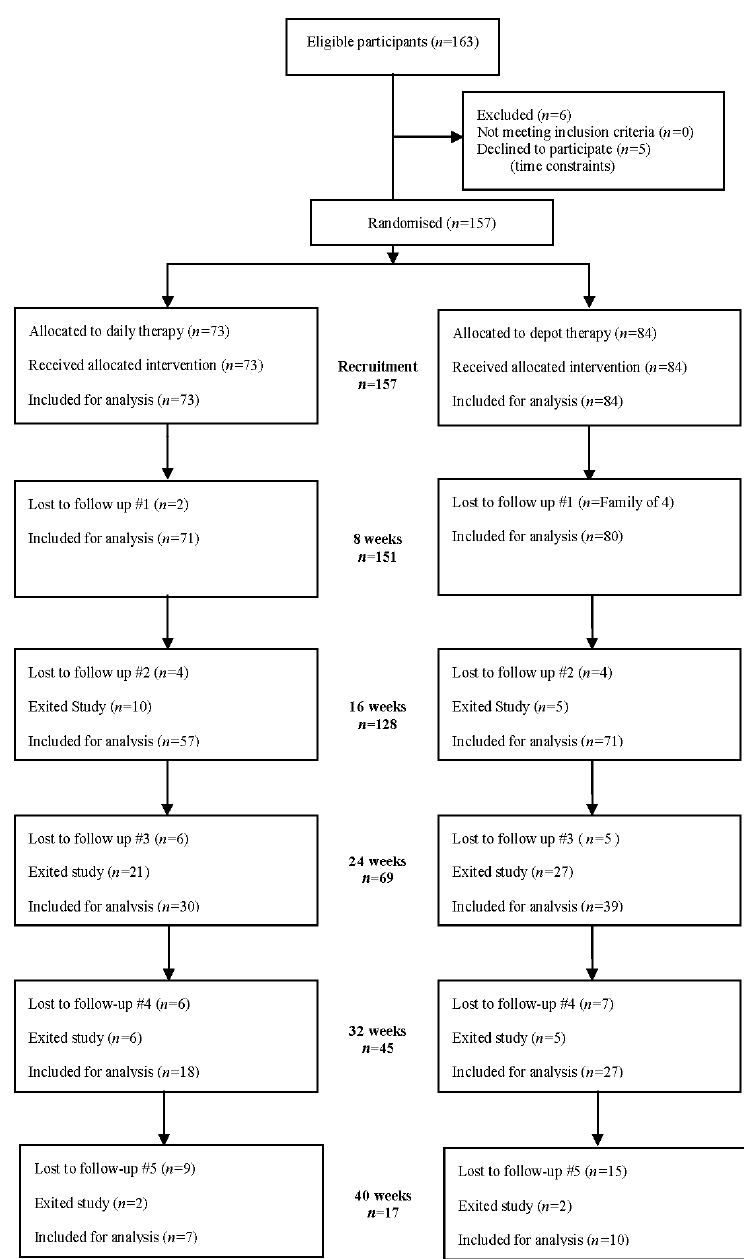
Figure 2. CONSORT flow diagram.